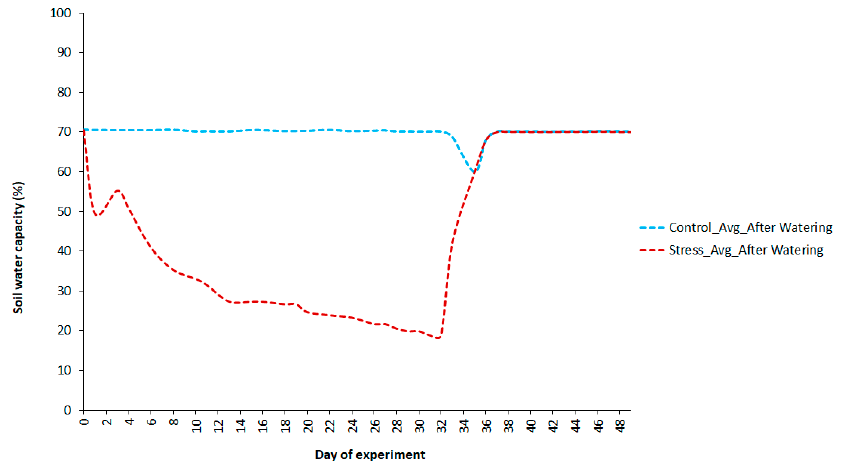
Figure 1. SWC (%) of pots after they were irrigated on the phenotyping platform from 29 April 2018 (day 0; both drought-stressed and control plants were irrigated to the same level of 70% of the maximum SWC) to 17 June 2018 (day 49). The soil of the drought-stressed plants continually dried to the permanent wilting point (15% of the SWC) on the 32nd day of the experiment, at which point the pots were irrigated to the level of 70% of the SWC, and the plants were allowed to recover for 17 days. The plants were subsequently transported to the vegetation hall after 49 days of being on the phenotyping platform.